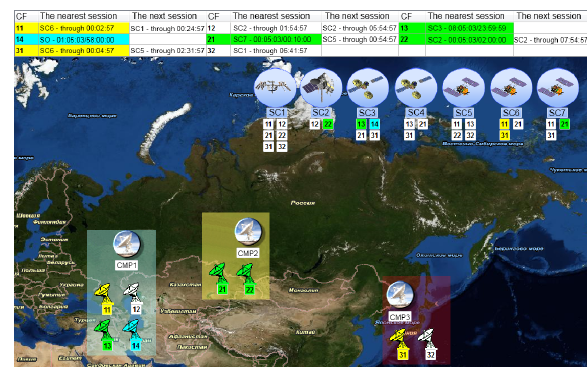
Figure 7. The operative presentation data about the current situation in the schematic form (CF - control facility, SC - spacecraft, CMP - control and measurement point)